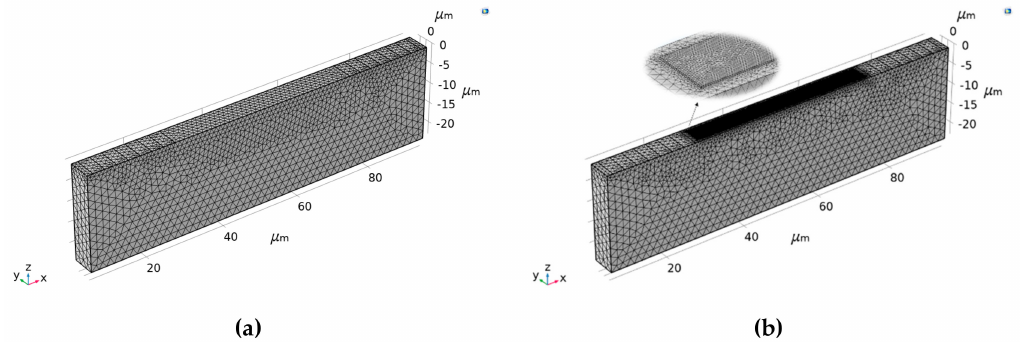
Figure 3. The geometry used for the three-dimensional finite element analysis (3D-FEA) simulation, ( a ) without a wave-guide layer and ( b ) with a wave-guide